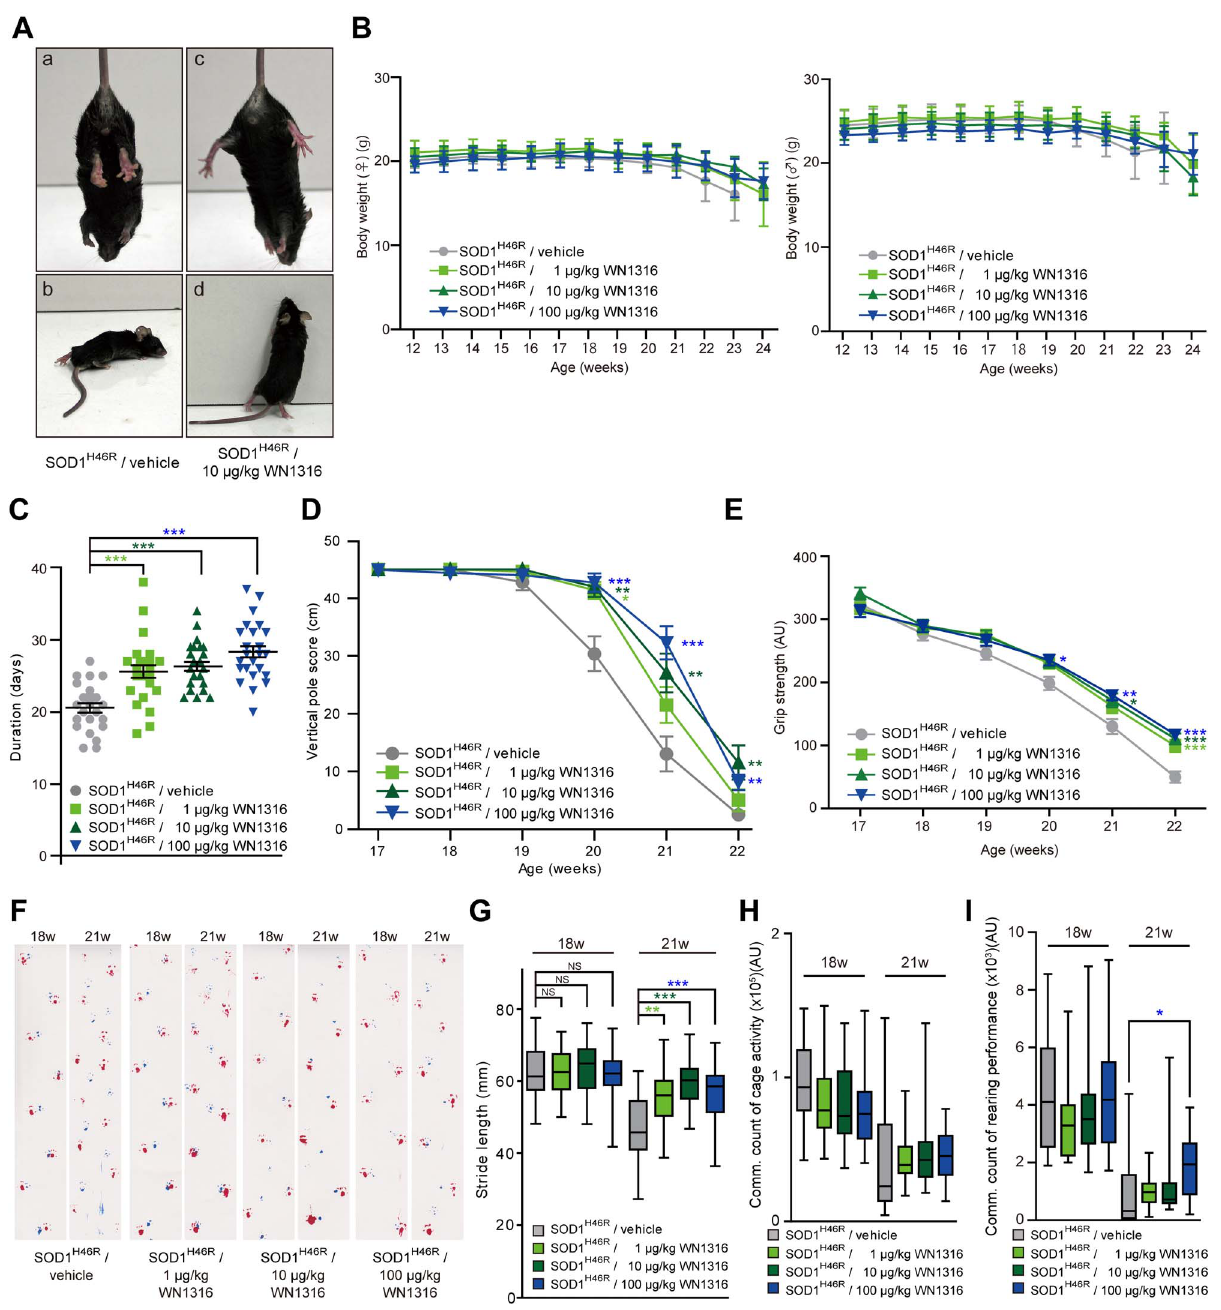
Figure 4. Invivo efficacy of WN1316 in ALS(SOD1 H46R ) mice. (A) Representative photographs of vehicle-treated (a and b) and WN1316-treated (c and d) ALS(SOD1 H46R ) mice showing a typical hind limb posture upon the tail suspension (a and c) and rearing behavior (b and d) at 157 days of age. (B) Changes in the body weight of female and male ALS(SOD1 H46R ) mice in vehicle (female, n=13 and male, n=13) and WN1316 [1 m g/kg, 10 m g/kg and 100 m g/kg (female, n=13 and male, n=13, respectively) ]-treated groups between 12 and 24 weeks of age. Data are expressed as mean 6 SD. (C) Scores of the balance beam test. Duration of date from the onset to the day at which each mouse was unable to stay on the bar was plotted. Data are expressed as mean 6 SEM [vehicle, 20.7 6 0.7 days (n=26), 1 m g/kg WN1316, 25.6 6 0.9 days (n=26), 10 m g/kg WN1316, 26.3 6 0.6 days (n=26) and 100 m g/kg WN1316, 28.4 6 0.8 days (n=26)]. *** p , 0.0001 by one-way ANOVA with Bonferroni’s post hoc test. (D) Vertical pole scores of vehicle (n=25) and WN1316 [1 m g/kg, 10 m g/kg and 100 m g/kg (n=26, respectively)]-treated mice between 17 and 22 weeks of age. Data are expressed as mean 6 SEM. * p , 0.05, ** p , 0.01 or *** p , 0.001 by non-parametric ANOVA (Kruskal-Wallis) with Dunn’s post hoc test when compared to the vehicle control. (E) Grip strength of vehicle (n=24) and WN1316 [1 m g/kg, 10 m g/kg and 100 m g/kg (n=26, respectively)]-treated mice between 17 and 22 weeks of age. Data are expressed as mean 6 SEM (AU; arbitrary unit). * p , 0.05, ** p , 0.01 or *** p , 0.001 by one-way ANOVA with Bonferroni’s post hoc test. (F) Footprints of vehicle and WN1316 (1 m g/kg, 10 m g/kg and 100 m g/kg)-treated mice at 18 and 21 weeks of age. Blue, front paws; red, hind paws. (G) Box-whisker plots of stride length. Data indicate the average distance between the hind paw steps in vehicle (n=21) and WN1316 [1 m g/kg, 10 m g/kg and 100 m g/kg (n=26, respectively)]-treated mice at 18 and 21 weeks of age. * p , 0.05, ** p , 0.01 or *** p , 0.001 by one-way ANOVA with Bonferroni’s post hoc test. NS; not significant. (H) The cage activity and (I) rearing performance of vehicle and